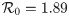
(a) Single-site basic reproduction number values as a function of the relative controlled death rate μi/μ0 and relative controlled emergence rate Λi/Λ0, assuming model parameters given in Table 1. These values also represent the homogeneous system basic reproduction numbers when μi and Λi are uniform across the neighborhood, as well as the no-hopping basic reproduction numbers when μi and Λi are the non-compliant death and emergence rates. Control efficacy increases along the μi/μ0 axis and decreases along the Λi/Λ0 axis. The case of no control is represented by the upper left corner where R0=1.89, and the red line indicates R0=1. Control efficacy for non-compliant sites is represented along the top of the plot where Λi = Λ0. (b) Infinitely fast hopping basic reproduction number values as a function of percent compliance, assuming model parameters given in Table 1. The black line represents the uncontrolled value R0∞=1.89, and the different color curves represent varying degrees of control efficacy in compliant and non-compliant sites. Blue represents strong compliant efficacy and weak non-compliant efficacy (μN = 1.25μ0, μC = 10μ0, ΛC = .5Λ0), orange represents moderate compliant efficacy and weak non-compliant efficacy (μN = 1.25μ0, μC = 5μ0, ΛC = .75Λ0), green represents strong compliant efficacy and moderate non-compliant efficacy (μN = 4μ0, μC = 10μ0, ΛC = .5Λ0), and red represents moderate compliant efficacy and moderate non-compliant efficacy (μN = 4μ0, μC = 5μ0, ΛC = .75Λ0).